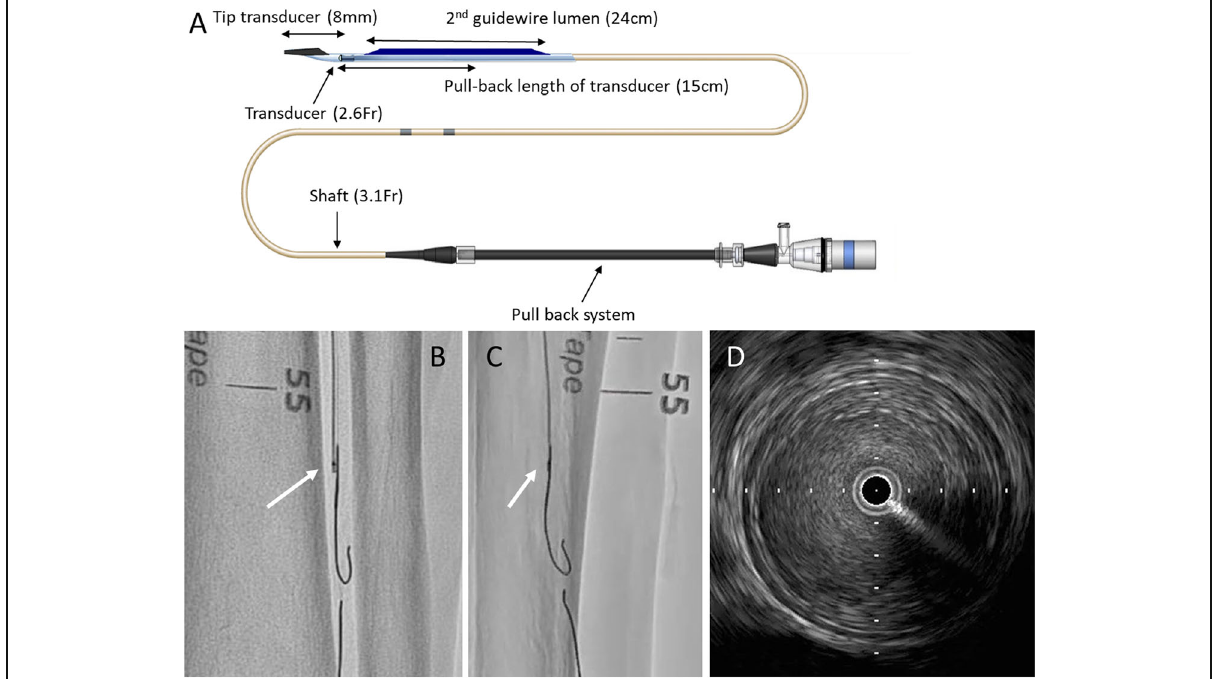
Fig. 1 a Structure of AnteOwl WR (AnteOwl) intravascular ultrasound (IVUS). b, c Angiographic images of AnteOwl IVUS. b is the right anterior oblique view, and the transducer is to the left of the IVUS wire. Alternatively, c is the left anterior oblique view, and the transducer and IVUS wire are almost the same. The positional relationship between the transducer and IVUS wire can be understood in this way using rotational angiography. d Typical image of a superficial femoral artery lesion on AnteOwl